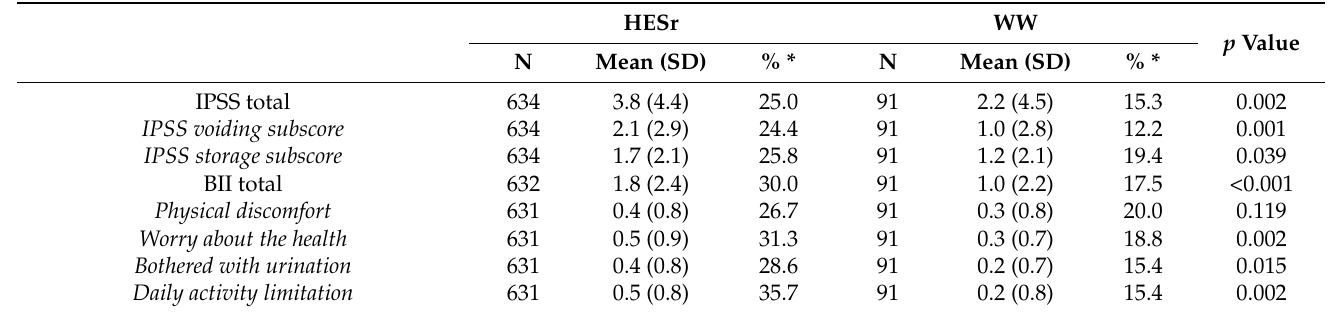
Table 2. Improvements from baseline to 6-month follow-up in symptoms and quality of life (iterative matching sample).